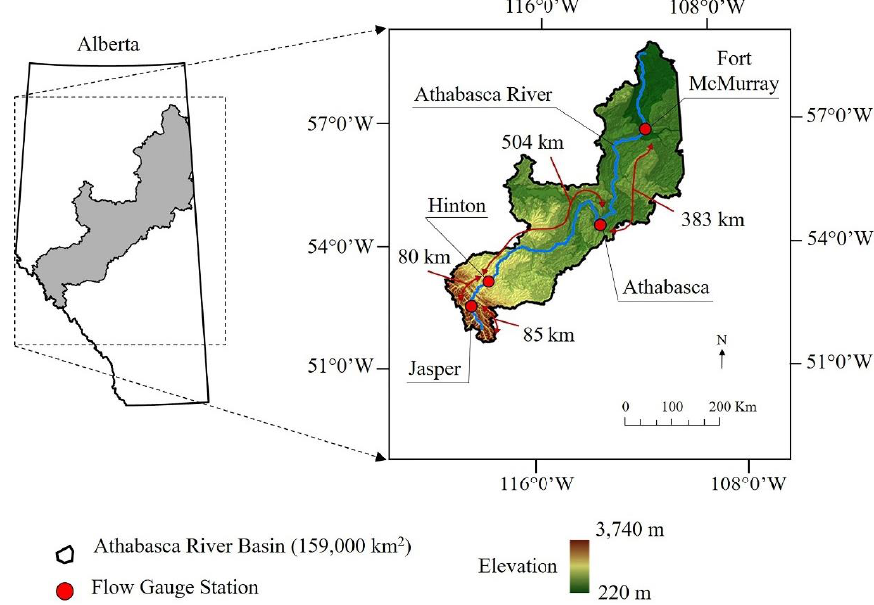
Figure 1. Area of study inclusive of the four gauging stations used for data acquisition. The image shows the Athabasca River from source to Fort McMurray, which is located near the mouth.